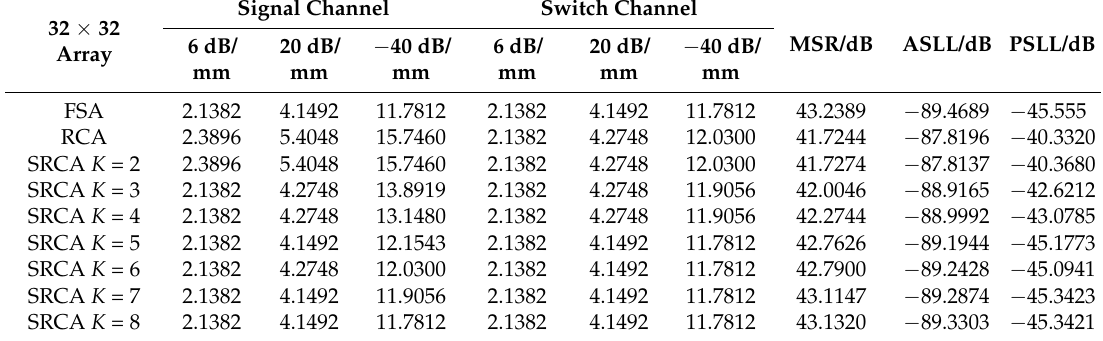
Table 3. The measured parameters of FSA, RCA and best split scheme of SRCA with K from 2 to 8 for a 32 × 32 array.